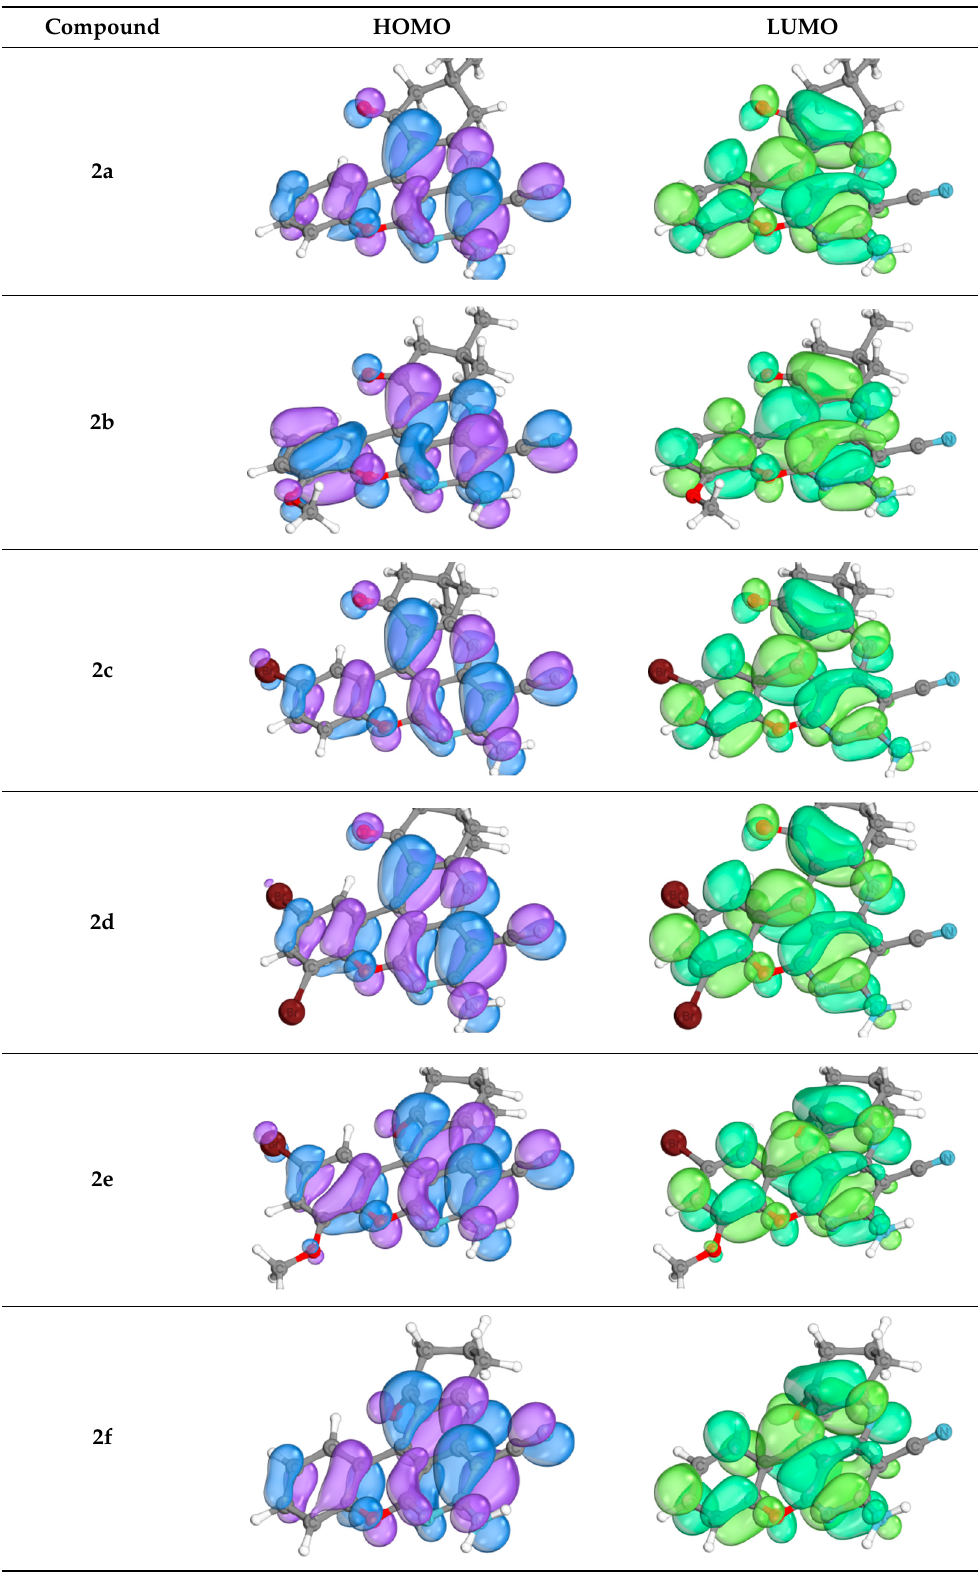
Table 4. Frontier orbitals of several studied compounds.